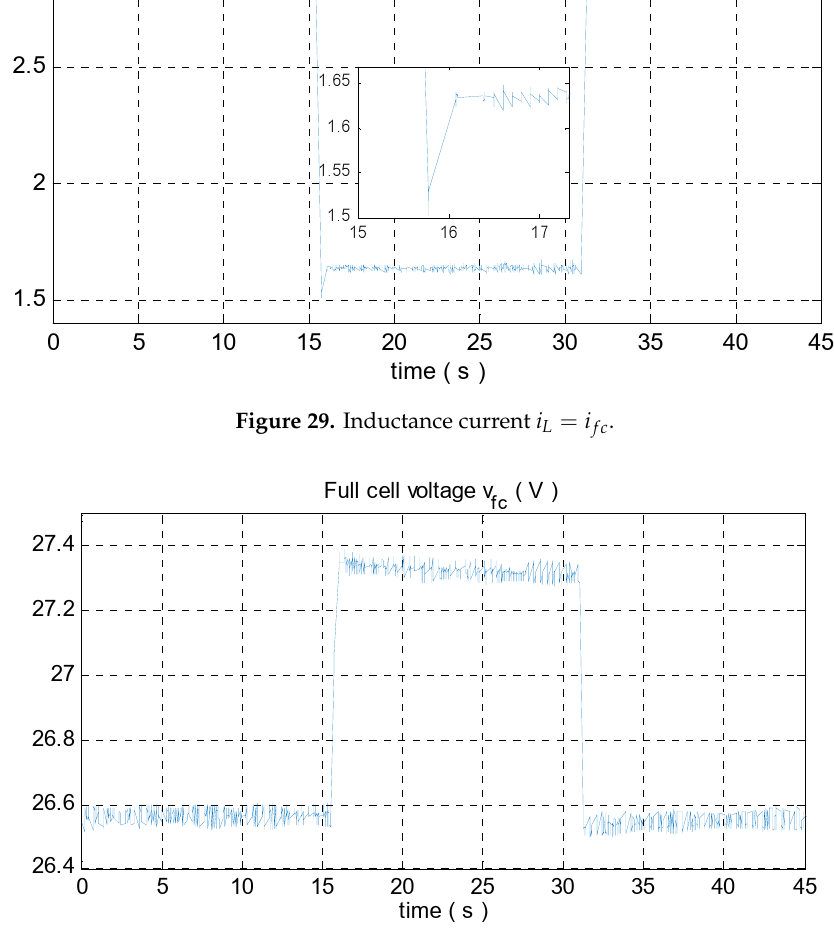
Figure 30. Fuel cell voltage V fc